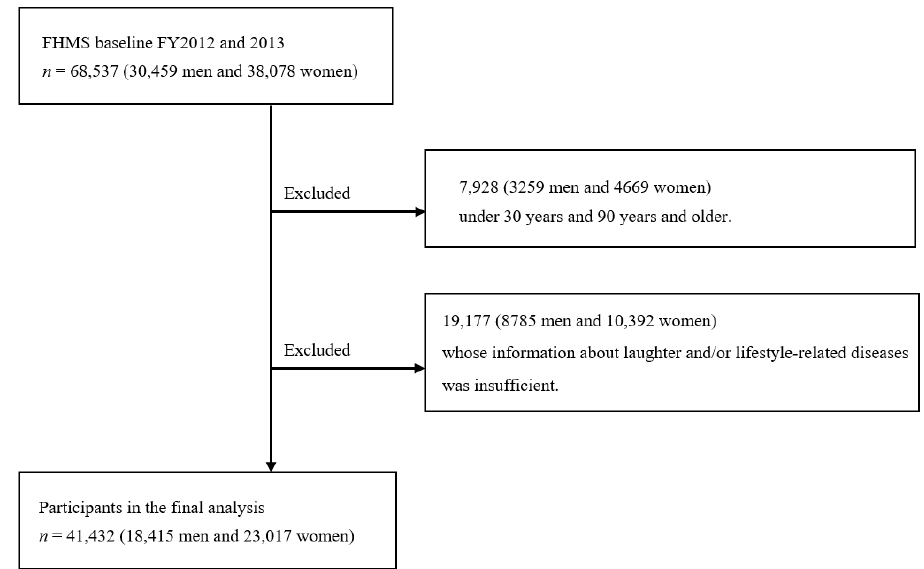
Figure 1. Flow chart of participant selection for the present study. Association between laughter and lifestyle diseases after the Great East Japan Earthquake: The Fukushima Health Management Survey.